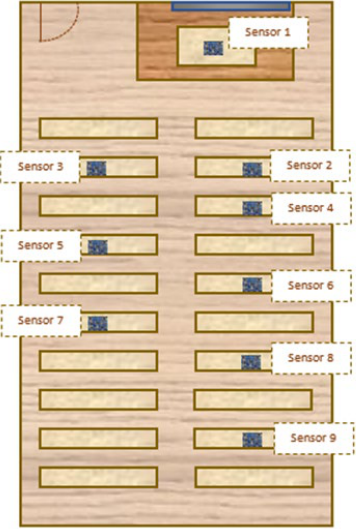
Figure 10. Location scheme of TSL2561 sensors in the scale model of the classroom of the Leonardo da Vinci building of the Rabanales University Campus of the University of Córdoba (Spain).